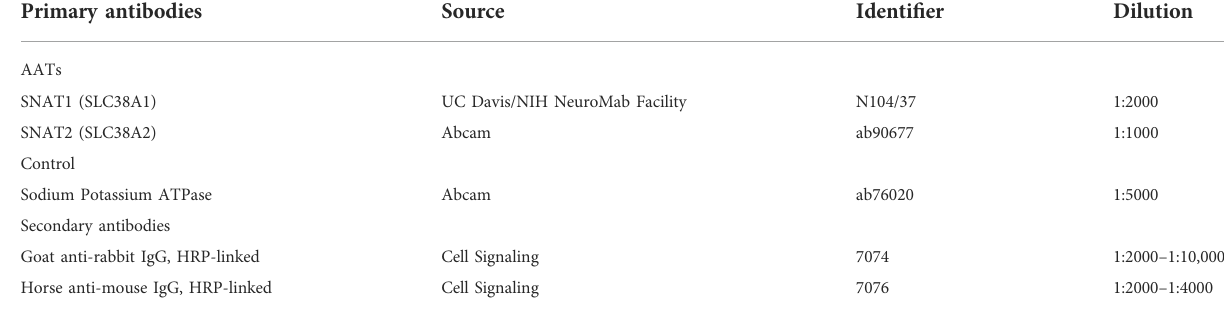
TABLE 1 Antibodies and their source and